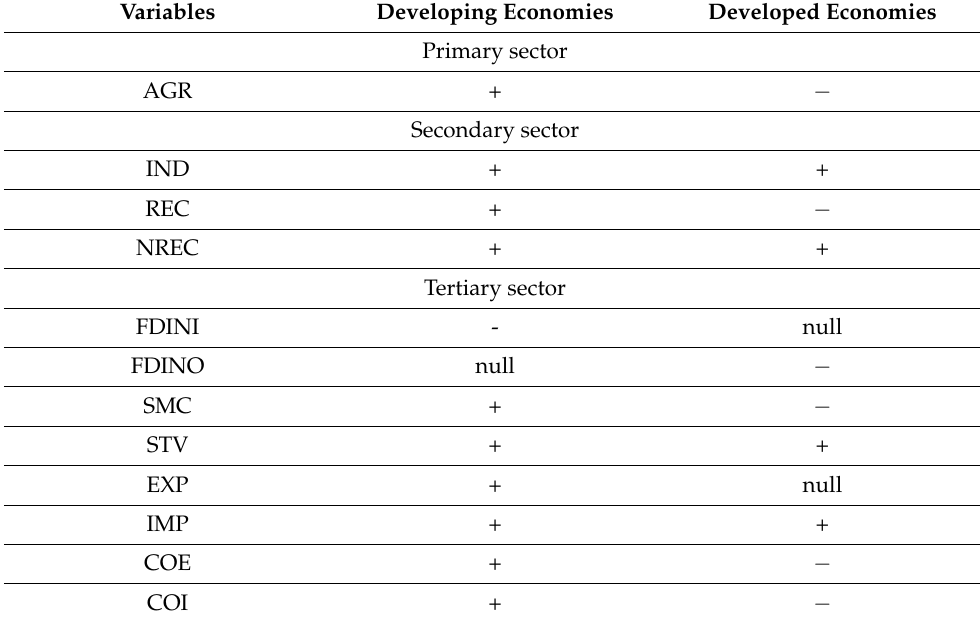
Table 8. FMOLS long-run results for the three-sector